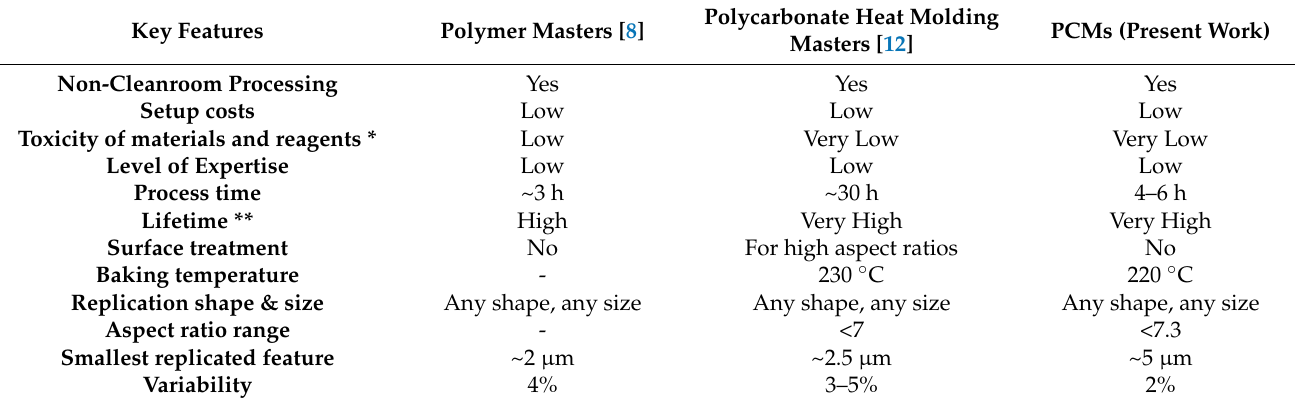
Table 1. Comparison of fabrication methods for soft lithography